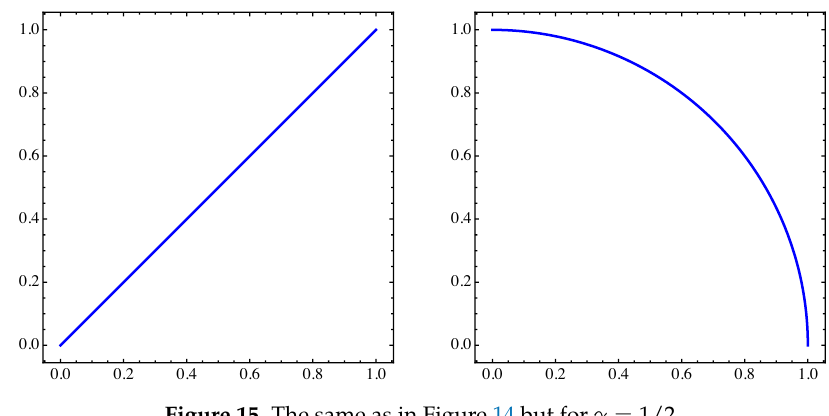
Figure 15. The same as in Figure 14 but for γ = 1/2.